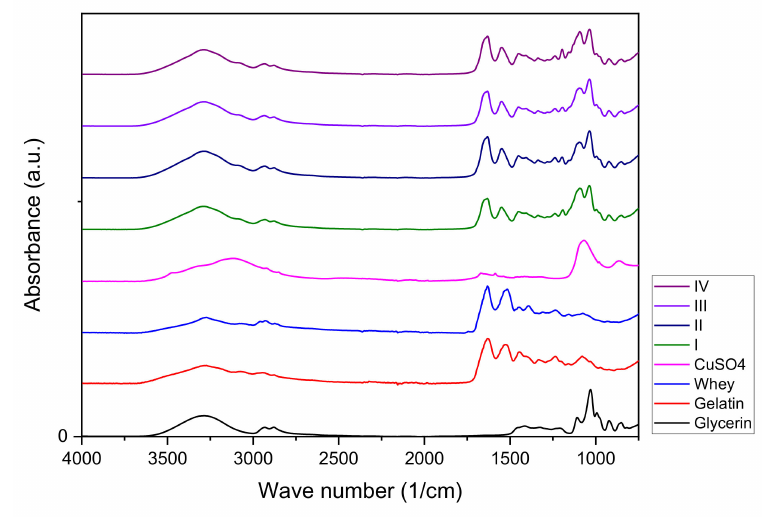
Figure 8. IR spectra of CuSO 4 × 5H 2 O, whey, glycerin, and gelatin and hydrogel samples with different amounts of copper.